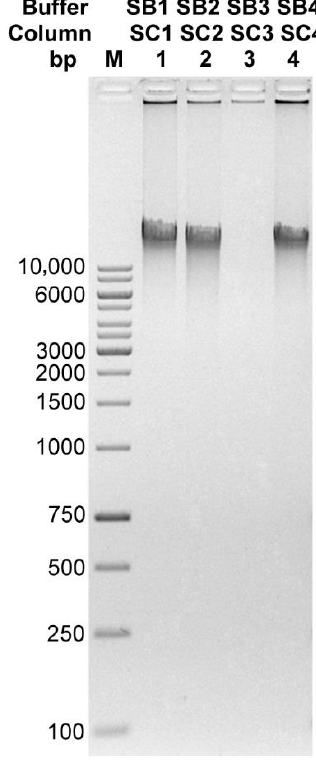
Figure 5. DNA of bacteriophage TP-84 extracted with four different commercially available lysis buffers together with dedicated spin-columns. Samples were electrophoresed on 1% agarose/TBE gel.